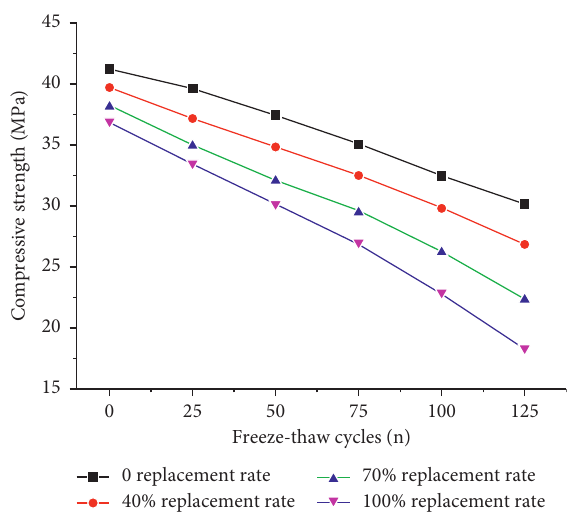
Figure 6: Flexural strength of coal gangue concrete under freeze- thaw